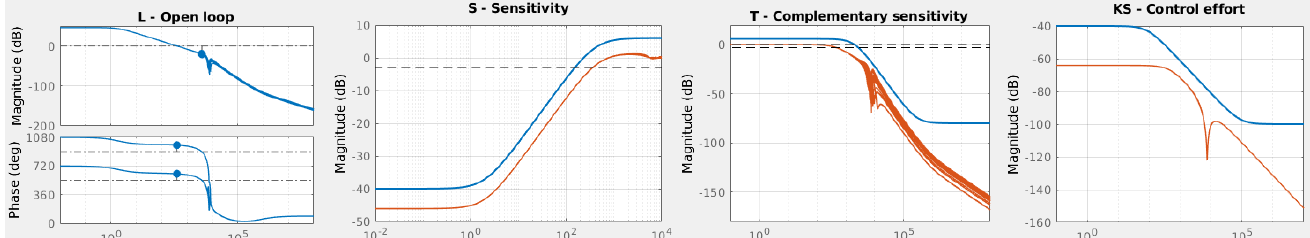
Figure 9. SEPIC-synthesized (order 21) vs. reduced (order 3) controllers; the peak µ value does not monotonically decrease with respect to controller order due to the influence of the ≈ 3750 [rad/s] notch over the converter resonance, which was not taken into account by the order reduction mechanism.